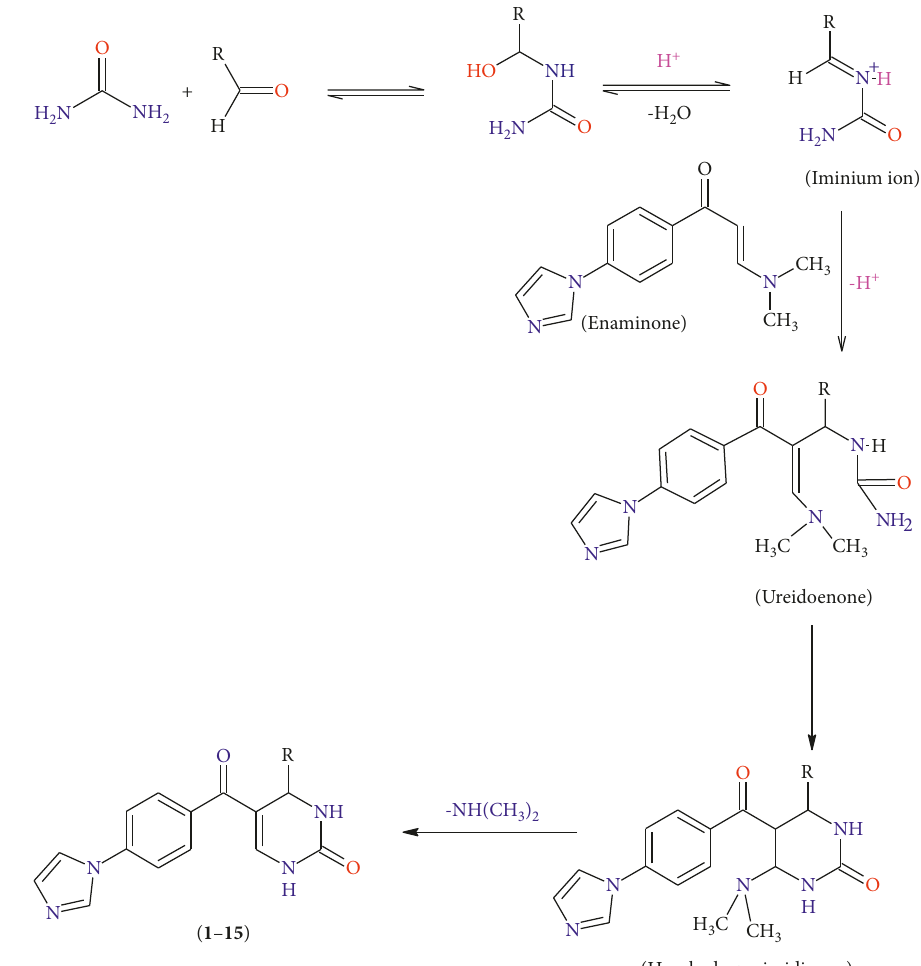
Scheme 2: Possible mechanism of the reaction for the synthesis of dihydropyrimidinone derivatives containing imidazole moiety ( 1 – 15